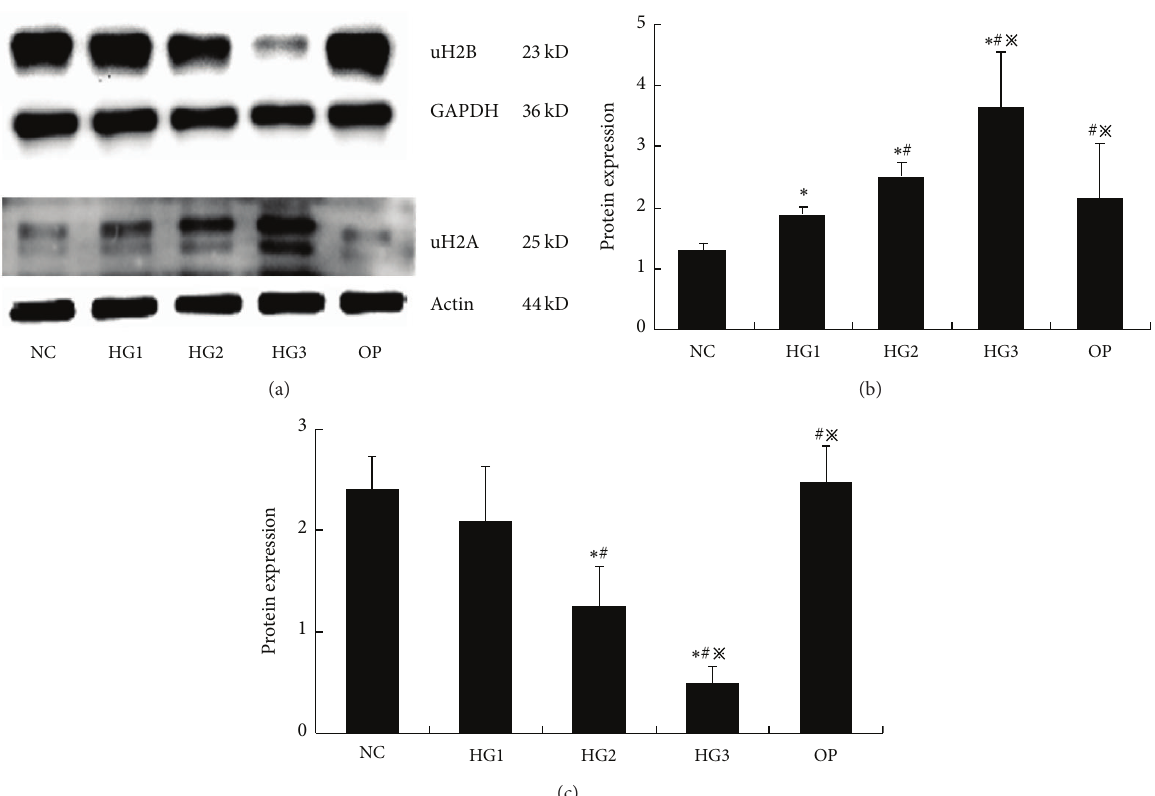
Figure3:TheexpressionofhistoneH2AandH2BubiquitinationineachgroupofGMCsbyWesternblot(48 hr).(a)uH2AanduH2Bproteins at different glucose concentrations and high osmotic pressure at 48hr: uH2A increased in the high glucose group and uH2B decreased as the glucose concentrations increased; they had the most significant changes in the HG3 group, but there were no apparent differences between the NC group and the OP group. (b) The gray graph shows the relative statistical values of uH2A for each group. The expression of the uH2A increased in the high glucose group, especially, in the HG3 group. ∗ 𝑃 < 0.01 versus NC group, # 𝑃 < 0.03 versus HG1 group, and n 𝑃 < 0.05 versus HG2 group. (c) The gray graph shows the relative statistical values of uH2B for each group. The expression of the uH2B proteins decreased by concentration dependency, obviously in HG3 group. ∗ 𝑃 < 0.01 versus NC group, # 𝑃 < 0.03 versus HG1 group, and n 𝑃 < 0.05 versus HG2